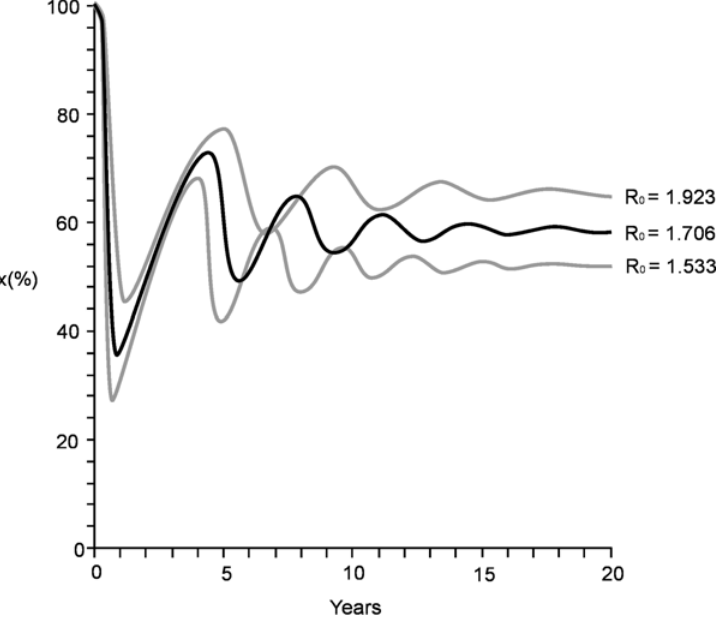
Figure 2. Temporal Pattern Model. Temporal pattern of the number of susceptible bats X(t) in M. myotis colonies, obtained by Anderson & May (1991) model, using R 0 = 1.706 and his 95% confidence interval.